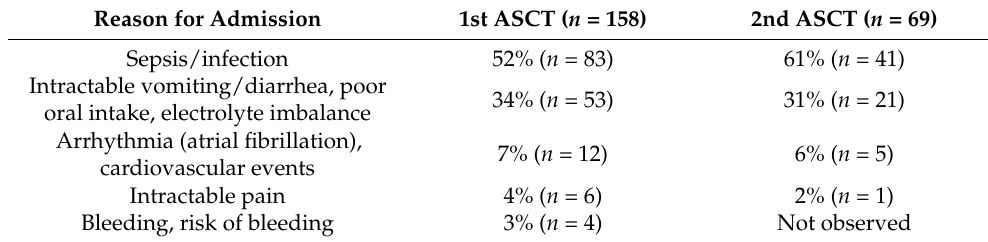
Table 2. Reasons for hospitalization of patients that initiated their ASCT on an outpatient